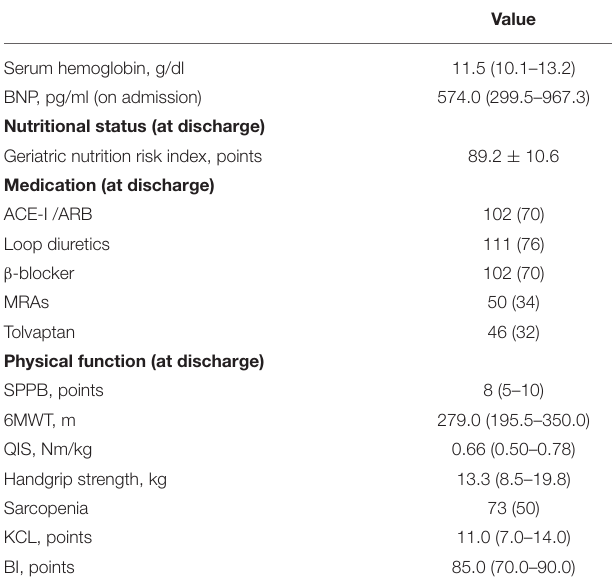
TABLE 1 | Baseline clinical characteristics of 146 patients with ADHF harboring